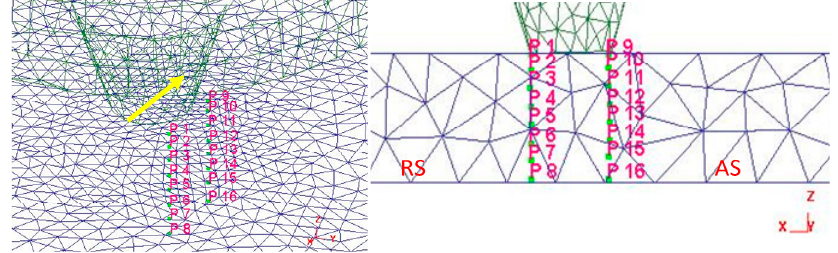
Figure 13. Advancing side tracking particle position setting.